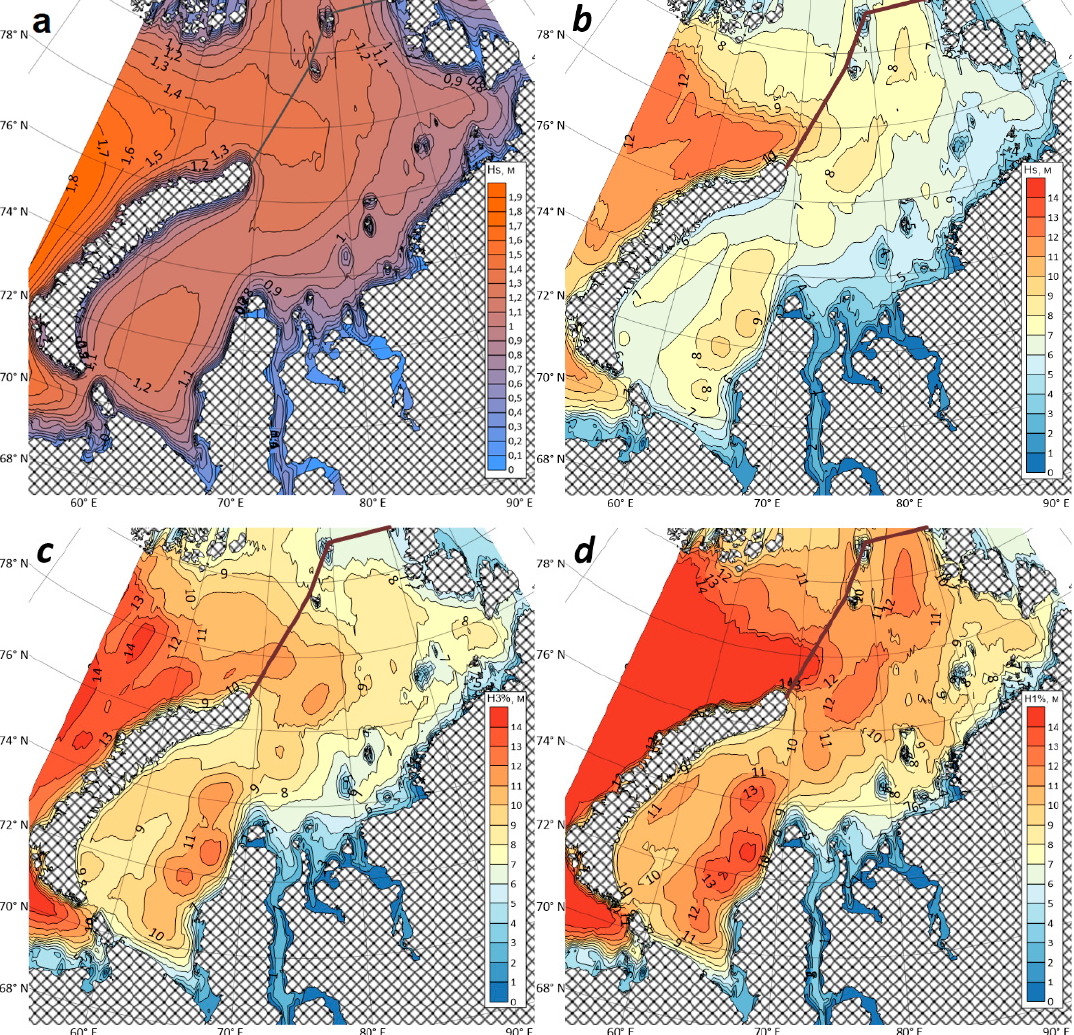
Figure 5. The long-term mean ( a ), maximum ( b ), significant wave heights, maximum wave height of 3% probability of exceedance ( c ), and maximum wave height of 1% probability of exceedance ( d ) according to the modeled data in the Kara Sea for the 1979 ‒ 2017 period.